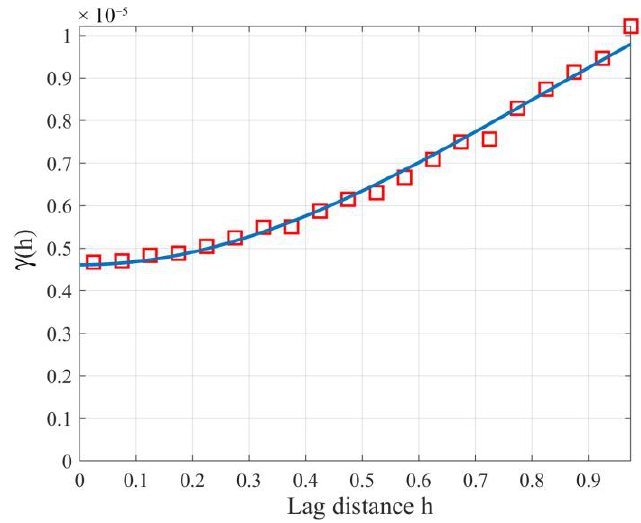
Figure 3. Experimental variogram and “Gaussian” variogram model.